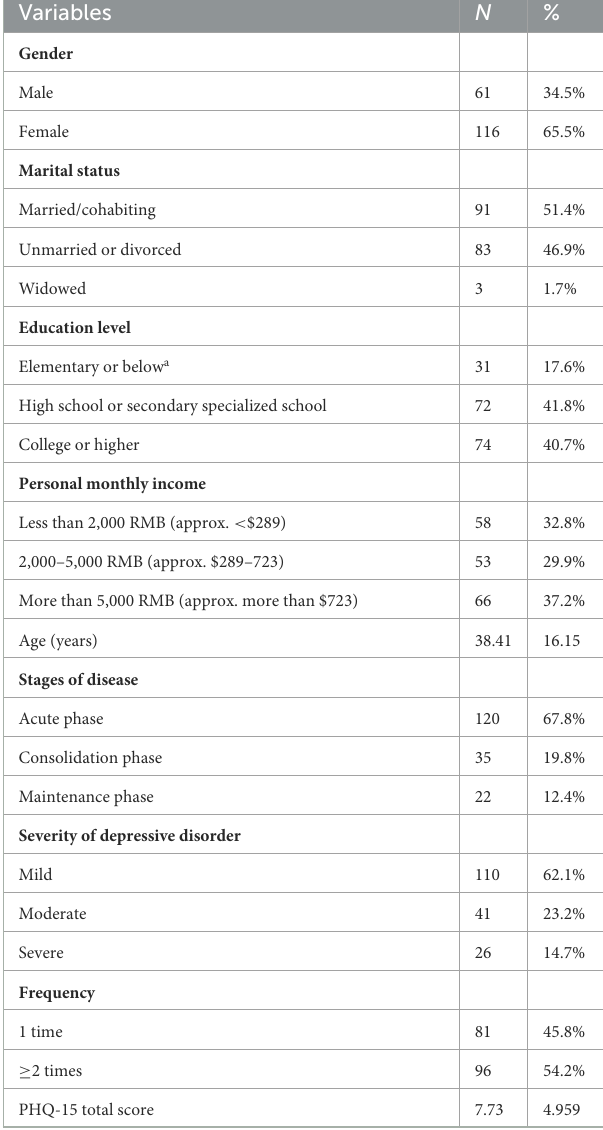
TABLE 1 Sociodemographic and clinical characteristics of participants ( N =